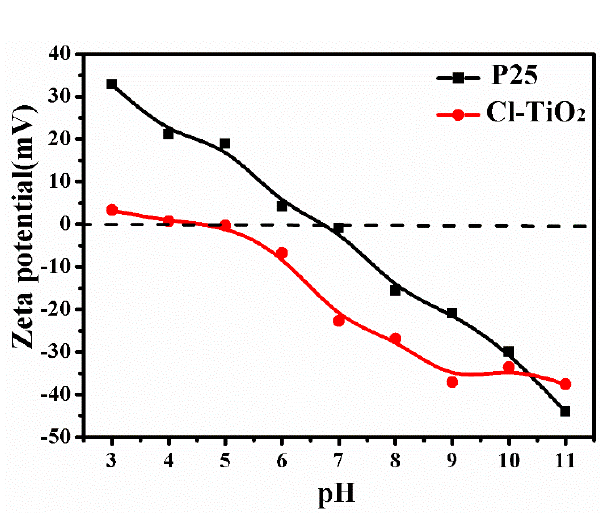
Figure 4. Zeta potentials of P25 and Cl-TiO 2 .